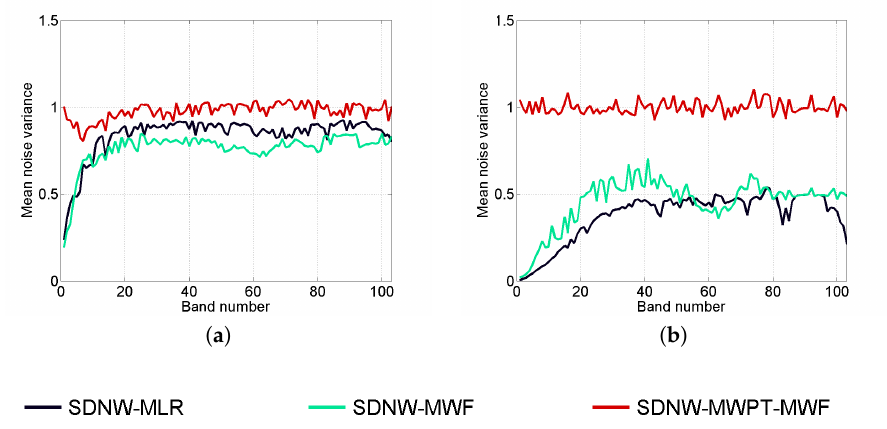
Figure 6. Curves of noise variance versus band number with SNR INPUT : ( a ) 20 dB; ( b ) 40 dB.